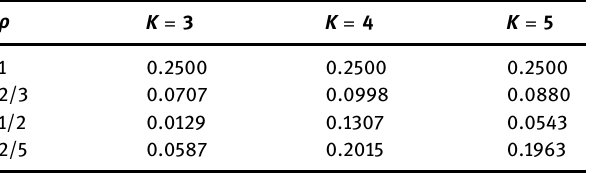
Table 7: The error for di ff erent values of ρ and for di ff erent number of non zero terms ( K ) in the series solution by the D ( TQ ) M (